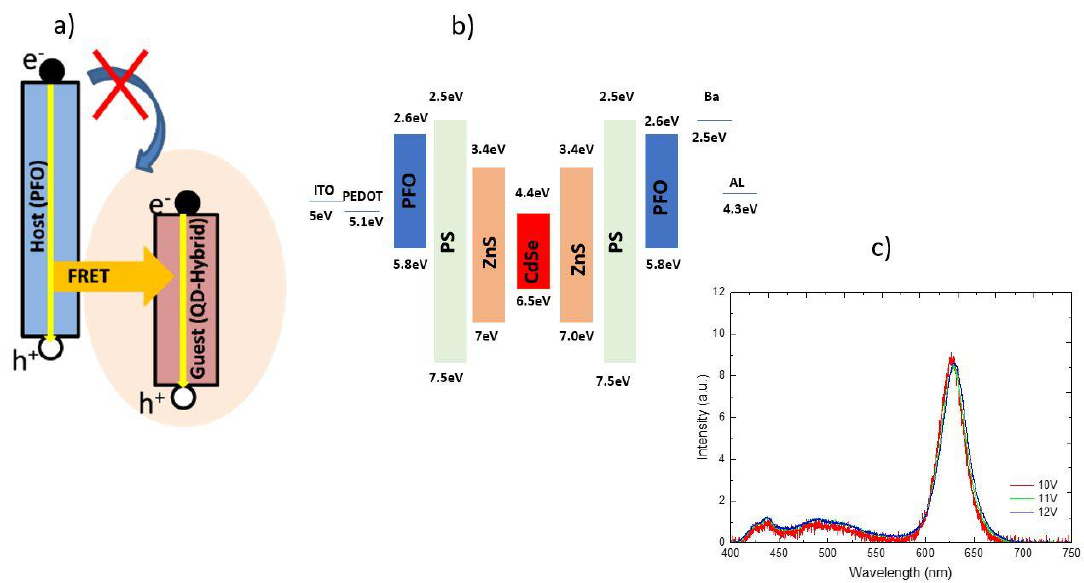
Figure 15. Schematic representation ( a ) of the general concept of preventing traps for charges by placing fluorescent guests inside a semiconducting polymer; coating the QD with a thin polystyrene shell (see energy diagram in ( b )) can block the transfer of charges to the QD; the transfer of energy from the semiconducting matrix to the QD can, however, still proceed via Foerster transfer. The resulting electroluminescence ( c ) is voltage independent. See [142] for more information.